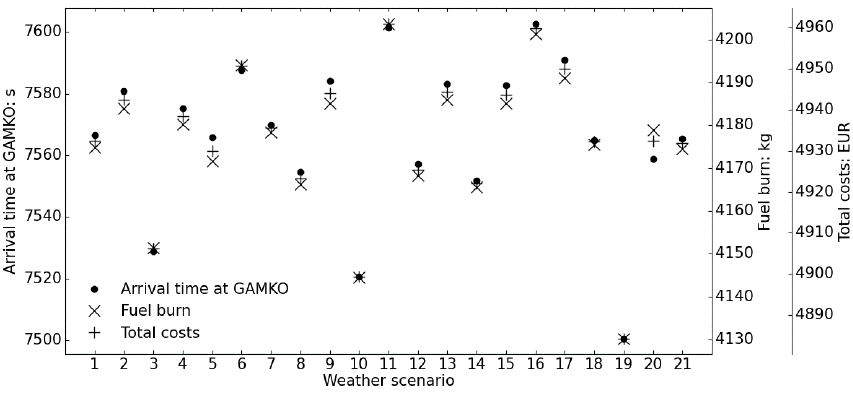
Figure 9. Arrival time at GAMKO, fuel burn and operational costs of the robust trajectory for each weather scenario ( C I = 30 kg/min, RTA not